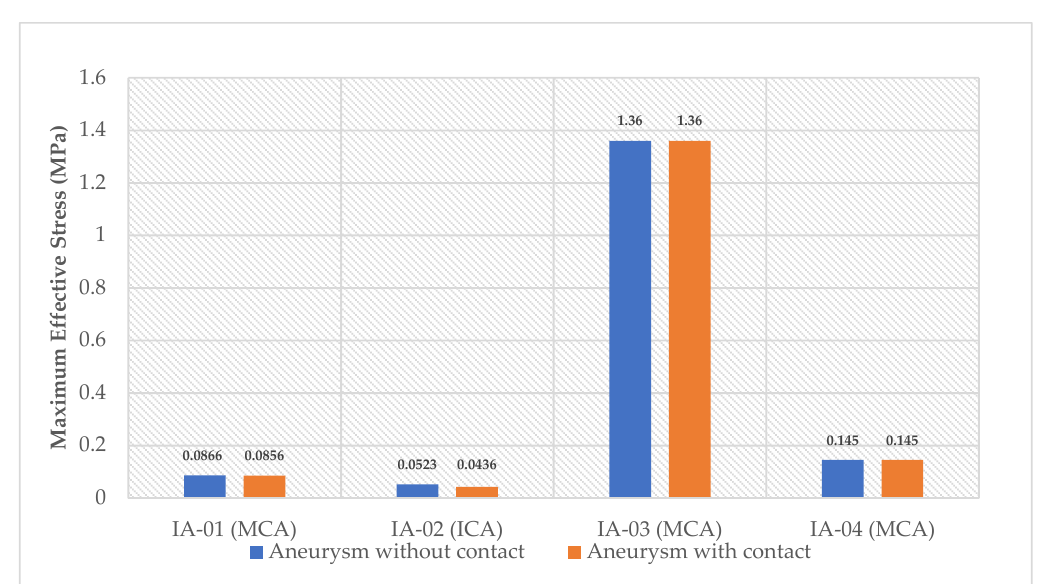
Figure 3. Comparison of maximum effective stress (MPa) of patient-specific intracranial aneurysms between cases without contact constraint and cases with plane contact constraint.